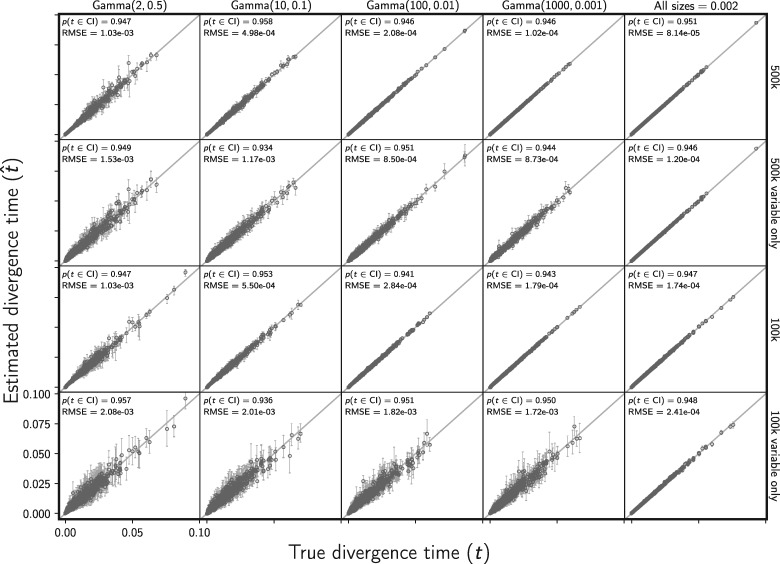
The accuracy and precision of divergence time estimates, in units of expected subsitutions per site, when data are simulated and analyzed under the same model (i.e., no model misspecification). The first four columns show the results from different distributions on the relative effective size of the ancestral population, decreasing in variance from left to right. The fifth column shows results when the effective size (\documentclass[12pt]{minimal}
\usepackage{amsmath}
\usepackage{wasysym}
\usepackage{amsfonts}
\usepackage{amssymb}
\usepackage{amsbsy}
\usepackage{upgreek}
\usepackage{mathrsfs}
\setlength{\oddsidemargin}{-69pt}
\begin{document}
}{}$N_{e}{\mu}$\end{document}) of all populations is fixed to 0.002. For the first two and last two rows, the simulated character matrix for each population had 500,000 and 100,000 characters, respectively. The first and third rows show the results of analyses using all characters, whereas the second and fourth rows show the results when only variable characters are used. Each plotted circle and associated error bars represent the posterior mean and 95% credible interval for the time that a pair of populations diverged. Each plot consists of 1500 estimates—500 simulated data sets, each with three pairs of populations. For each plot, the root mean square error (RMSE) and the proportion of estimates for which the 95% credible interval contained the true value—\documentclass[12pt]{minimal}
\usepackage{amsmath}
\usepackage{wasysym}
\usepackage{amsfonts}
\usepackage{amssymb}
\usepackage{amsbsy}
\usepackage{upgreek}
\usepackage{mathrsfs}
\setlength{\oddsidemargin}{-69pt}
\begin{document}
}{}$p({{t}}\in \textrm{CI})$\end{document}—is given. We generated the plot using matplotlib Version 2.0.0 (Hunter 2007).